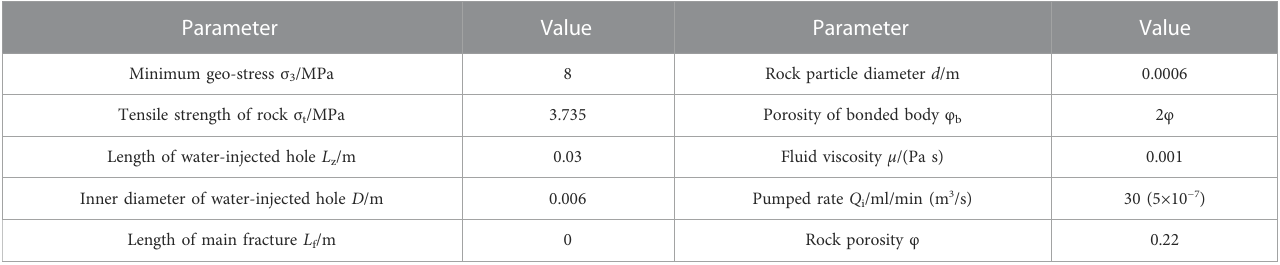
TABLE 4 Basic parameters of rock fracturing.